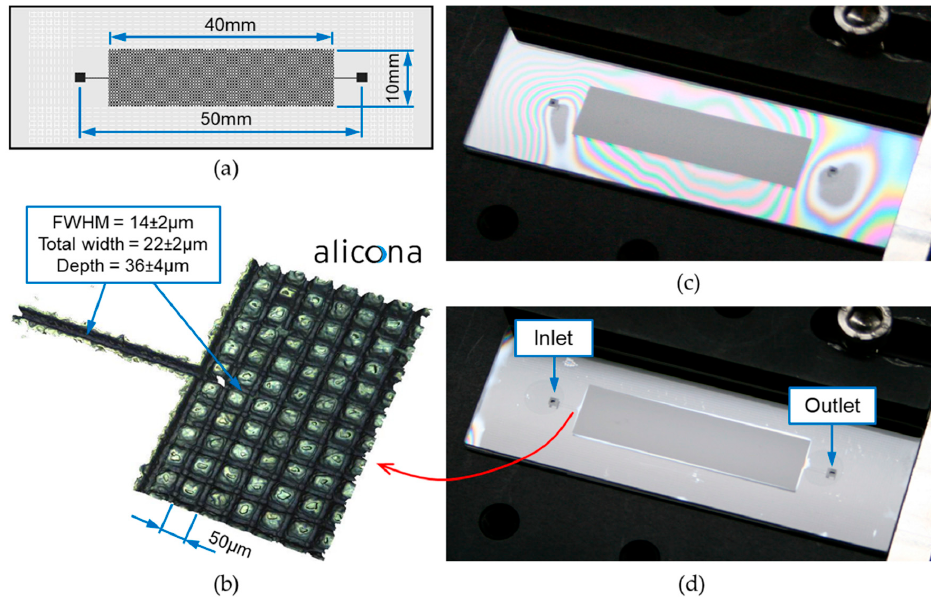
Figure 8. Example of laser-manufactured microfluidic device: ( a ) design; ( b ) 3D surface profile of its internal structure; ( c , d ) microfluidic device before and after laser microwelding, respectively.